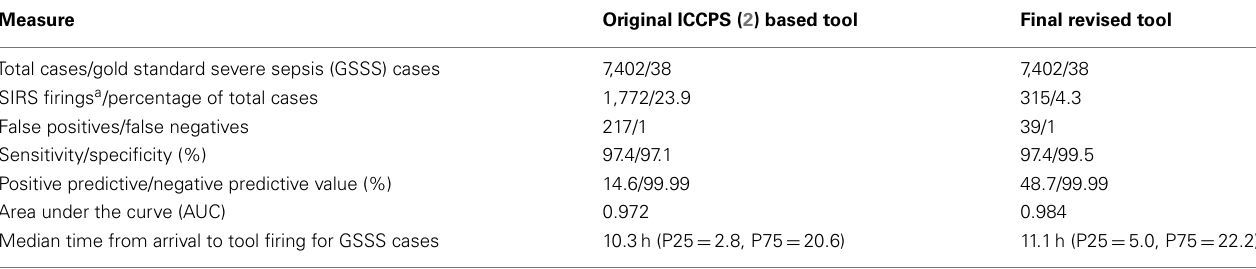
Table 6 | Comparison of initial and final versions of the pediatric severe sepsis screening tool .